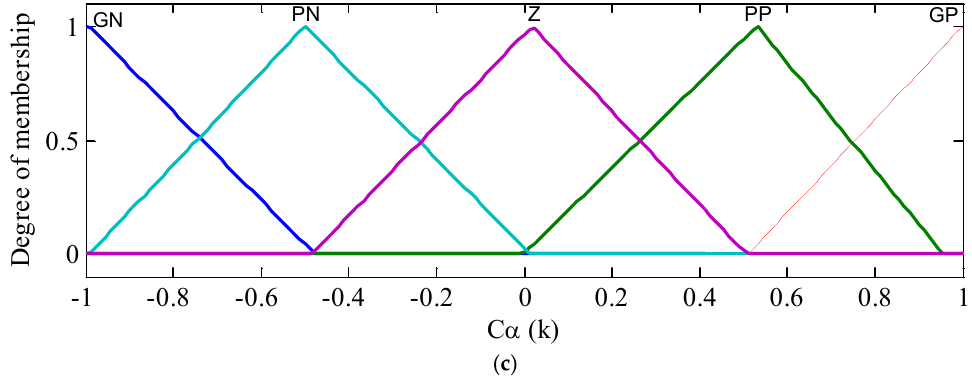
Figure 5. Fuzzy logic controller membership functions: ( a ) error membership function, ( a ) change er- ror membership function and ( b ) evolution of target, and ( c ) change duty cycle membership function. Table 2. Rule-based table of the fuzzy logic controller.